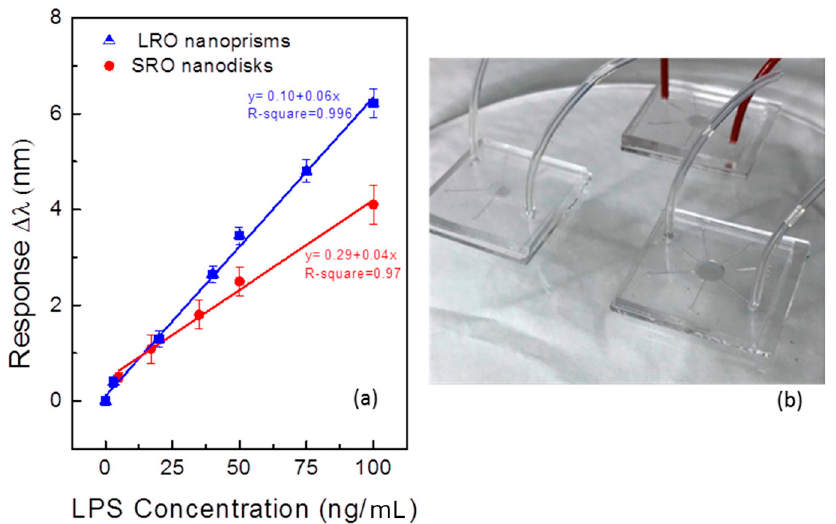
Figure 6. ( a ) Calibration curves of the functionalized plasmonic systems exposed to increasing concentrations of LPS. Trend line equations and R-square values are reported for each set of trans- ducer. ( b ) Picture of the miniaturized lab-on-a-chip (LOC) platform based on the integration of nano-structured Localized Surface Plasmon Resonances (LSPR) transducers into a 2.5 × 2.5 cm 2 polydimethylsiloxane (PDMS) microfluidic